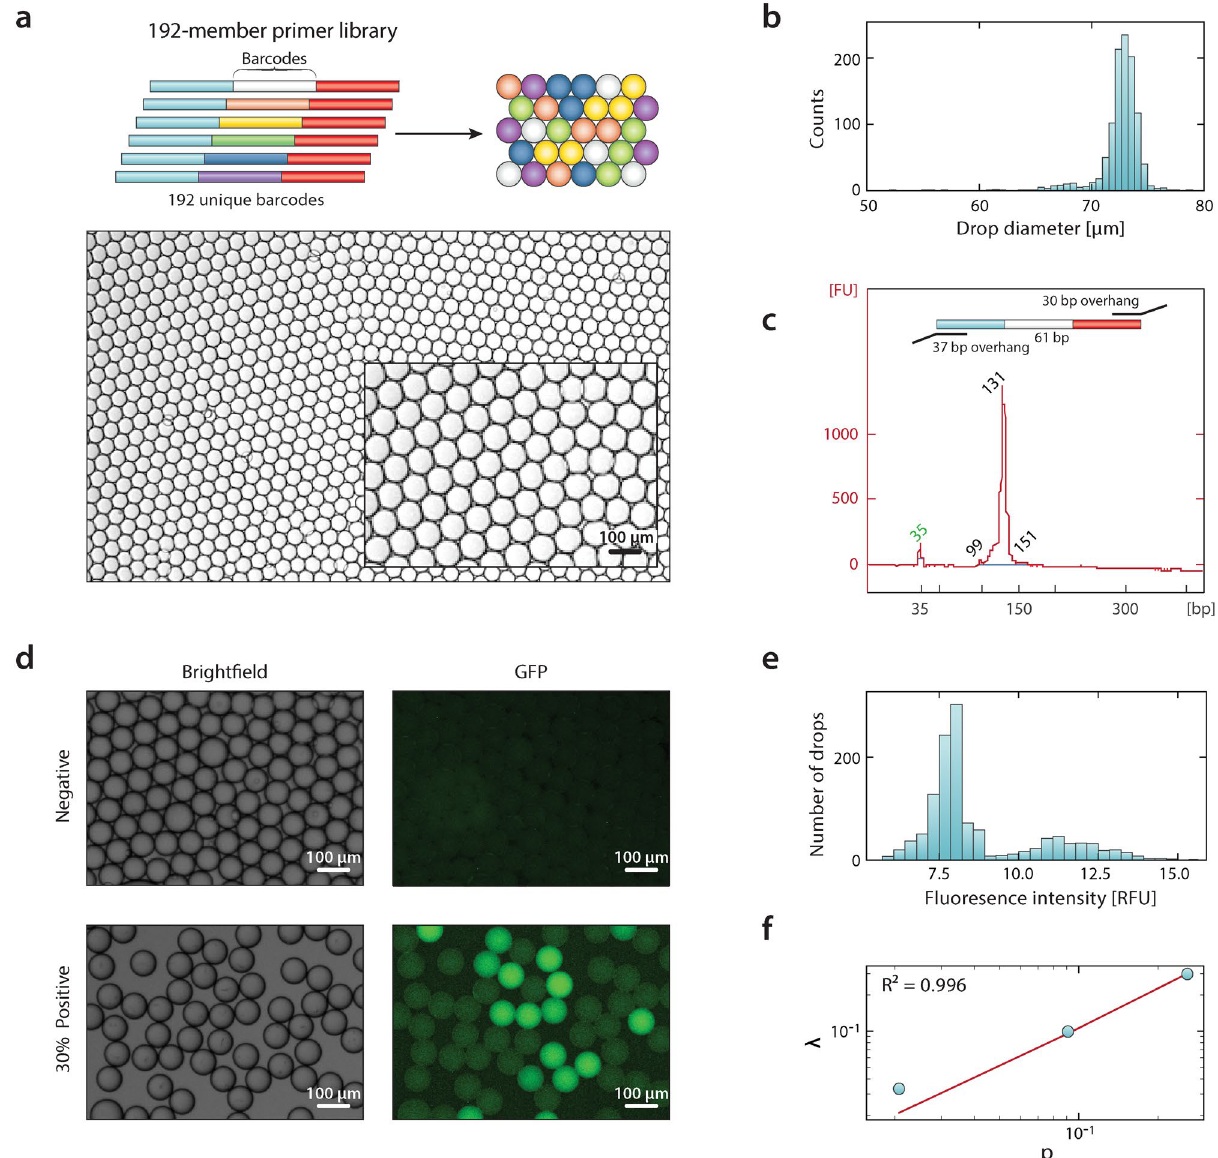
Figure 4. Amplification of oligonucleotides encapsulated within droplet libraries. ( a ) A library consisting of oligos consisting of one of 192 barcode sequences flanked by constant regions is encapsulated within droplets. ( b ) Histogram of the size distributions of droplets in the emulsion. ( c ) Encapsulated oligos are amplified by primers targeting the constant regions. DNA electropherogram confirms appropriately sized cDNA. ( d ) Micrographs of ΦX174 DNA co-encapsulated with digital droplet PCR reagents in brightfield and GFP channels for an emulsion without any ΦX174 DNA and where ΦX174 DNA is expected to be present in 30% of droplets. ( e ) Histogram of fluorescence intensity within droplets for the 30% positive emulsion. ( f ) Poisson estimator λ as a function of the percentage of positive droplets p , with an overlaid